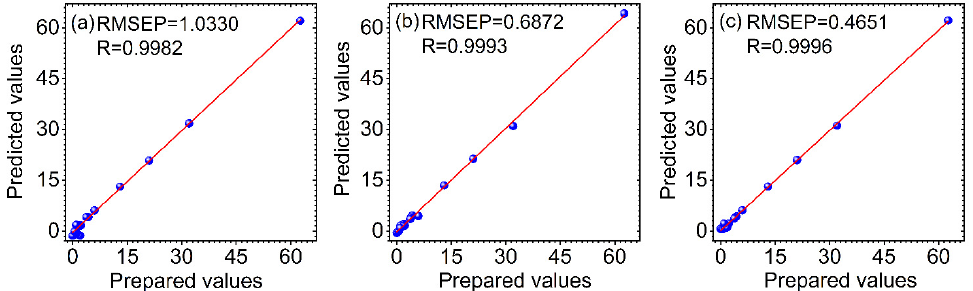
Figure 5. The relationship between the prepared and the predicted values for the prediction set by PLS ( a ), SVR ( b ) and VMD-WMSVR ( c ) for the adulterated vegetable oil dataset.